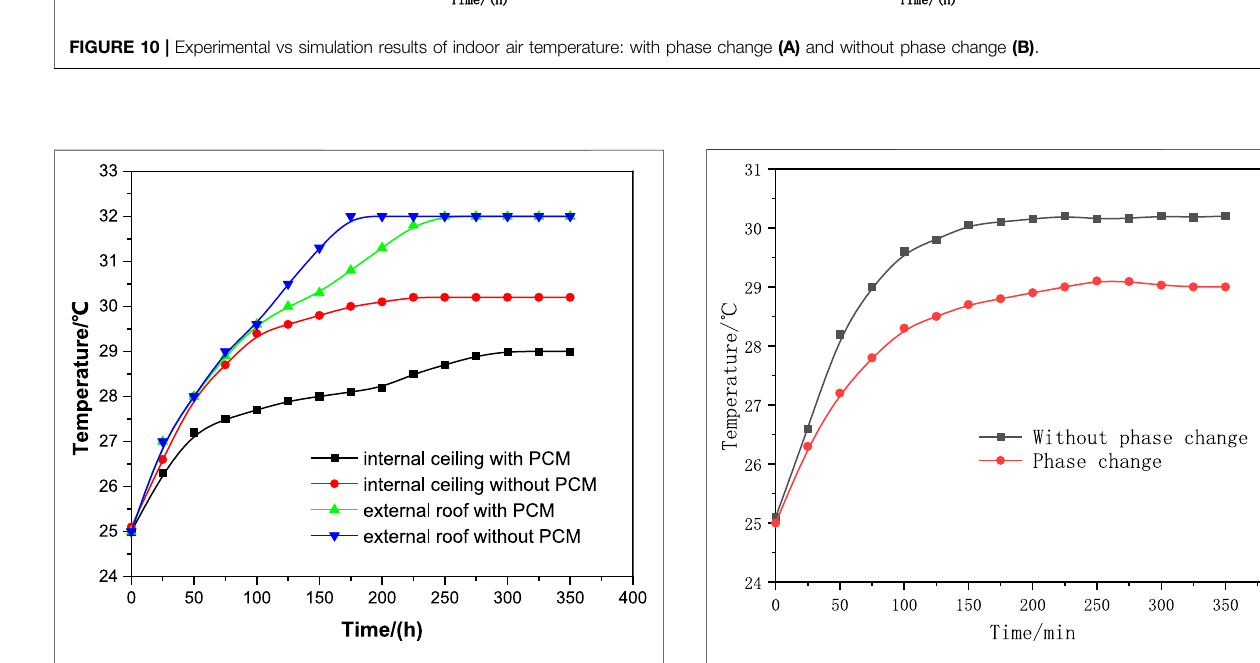
FIGURE 11 | Temperature change curves of the internal ceiling and the external roof of the building model with and without phase change.